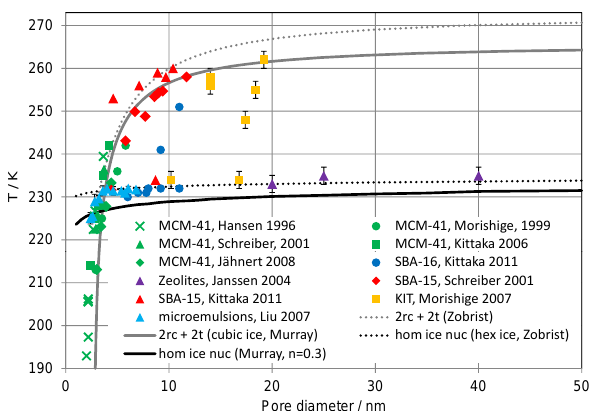
Fig. 3. Freezing in completely filled pores of different mesoporous materials. Data is taken from Hansen et al. (1996) (NMR spec- tra measured in 2K steps), Morishige and Kawano (1999) (X- ray diffraction patterns in ca. 2K steps), Schreiber et al. (2001) (DSC curves at 0.5Kmin − 1 , evaluation of peak maxima), Kittaka et al. (2006) (DSC curves at 5Kmin − 1 , evaluation of peak onset), Jähnert et al. (2008) (DSC curves at 0.5Kmin − 1 , evaluation of peak maxima), Kittaka et al. (2011) (DSC curves at 5Kmin − 1 , evalu- ation of peak onset), Janssen et al. (2004) (DSC at 0.5Kmin − 1 , evaluation of peak onset), Morishige et al. (2007) (DSC curves at 0.5Kmin − 1 , evaluation of peak onset), Liu et al. (2007) (DSC curves at 5Kmin − 1 , DTD (differential temperature difference) curves at 1Kmin − 1 ). Grey dotted and solid lines: pore diameter needed to incorporate a critical cluster of hexagonal (calculated with values from parameterization by Zobrist et al., 2007) and cu- bic ice (calculated with values from parameterization by Murray et al. (2010a), respectively. Black dotted and solid lines: parameteri- zations of homogeneous ice nucleation by Zobrist et al. (2007) and Murray et al. (2010a) with n = 0.3, respectively.